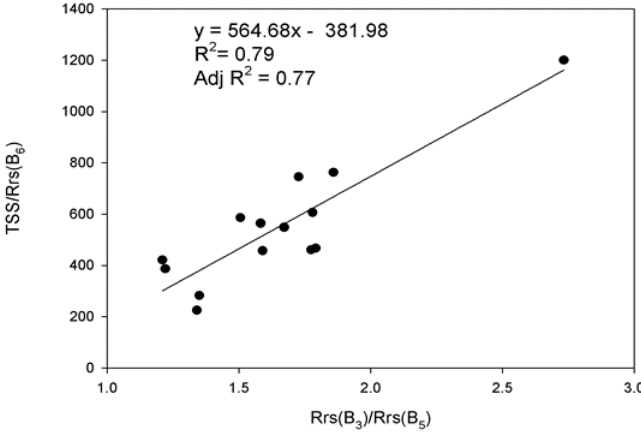
Figure 3. Regression model for TSS Concentration Over Study Region.